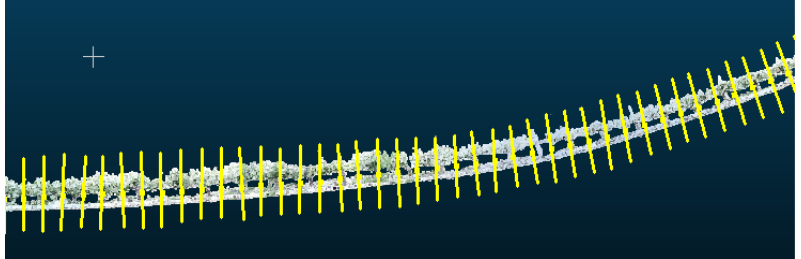
Figure 6. Part of the 3D reconstruction shown in Figure 2 split into sections.